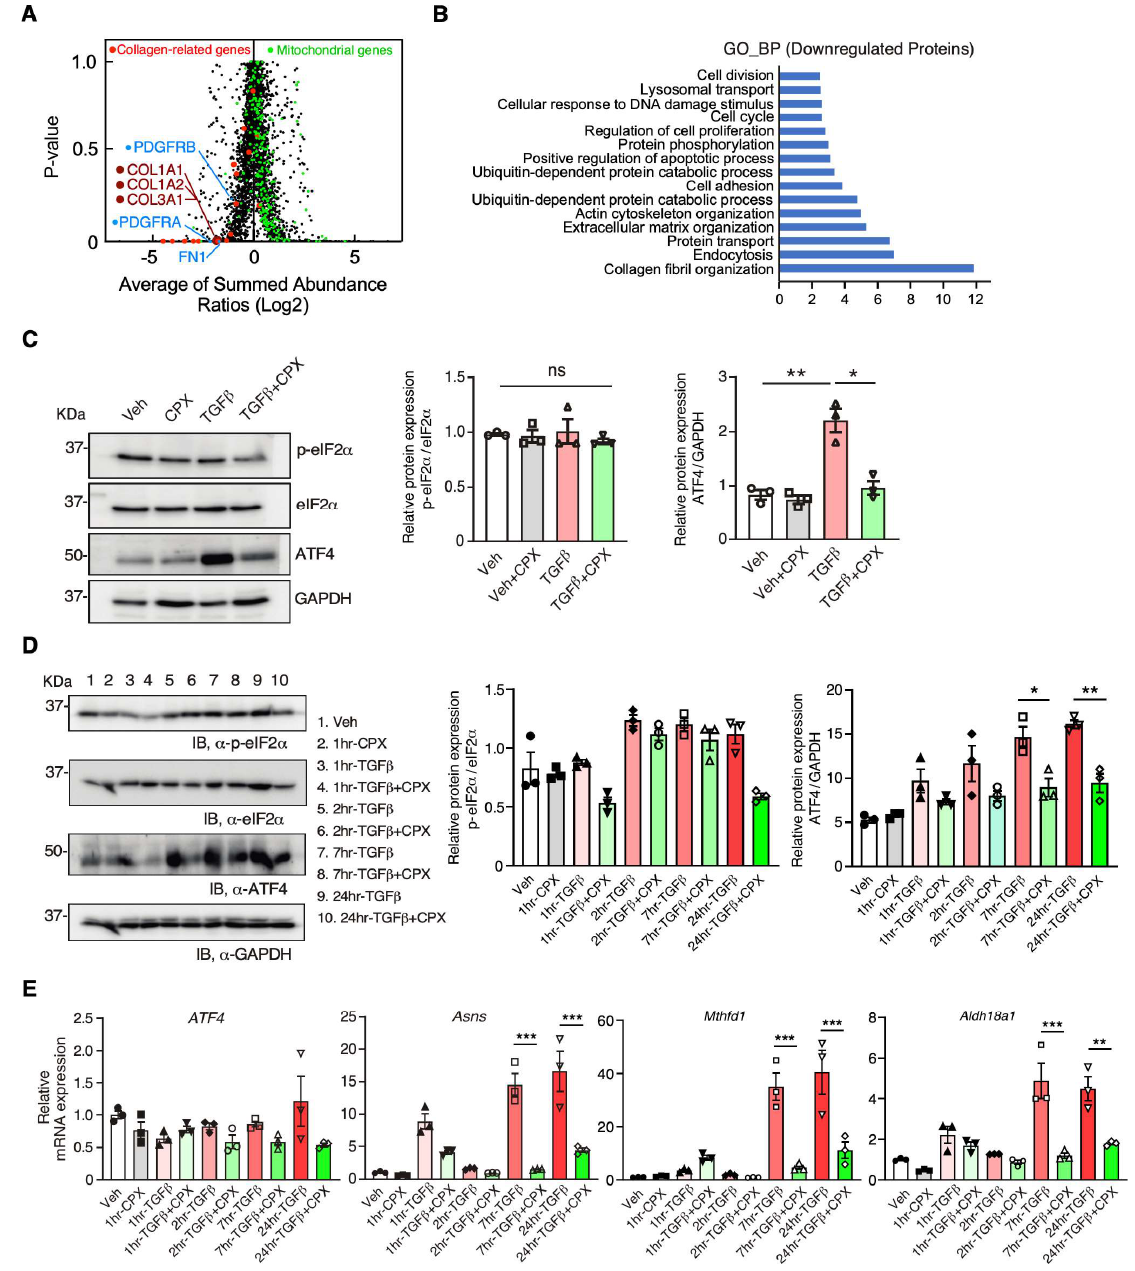
Figure 6. Proteomic reprogramming by ciclopirox in mouse cardiac fibroblasts. ( A ) Mass spectrometry analysis in 10 µ M CPX-treated primary mouse CFs compared to vehicle-treated cells (24 h treatment). ( B ) Gene ontology analysis of downregulated proteins in primary mouse CFs by CPX treatment. ( C ) Western blot analysis of p-eIF2 α , eIF2 α , and ATF4 protein expression in NIH/3T3 cells. NIH/3T3 cells were treated with TGF β (10 nM) concentration and CPX (10 µ M) at 24 h. Quantification of WB was shown on the right panel. ( D ) Western blot analysis of p-eIF2 α , eIF2 α , and ATF4 protein expression in NIH/3T3 cells. NIH/3T3 cells were treated with TGF β (10 nM) concentration and CPX (10 µ M) at 1, 2, 7, and 24 h in a time course. Quantification of WB was shown on the right panel. ( E ) RT-qPCR quantification of ATF4 mRNA and ATF4 target gene expression. n = 3 of independent experiments. * p < 0.05, ** p < 0.01, *** p < 0.001, ns: not significant by Two-way ANOVA with Tukey’s multiple comparisons